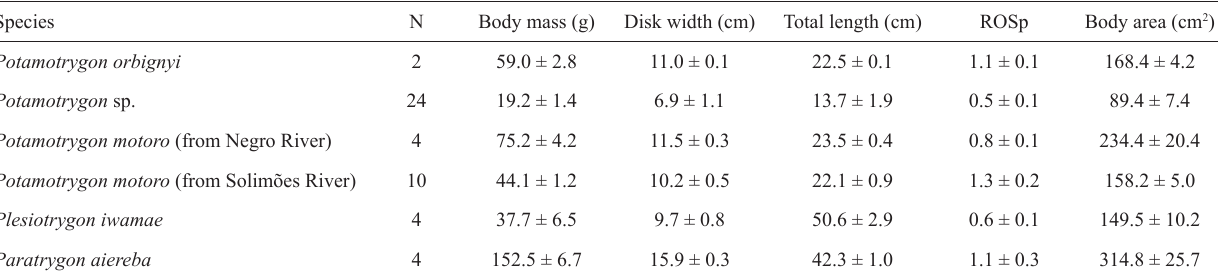
Table 2. Number of total filaments (mean ± S.E) on different gill arches among near-term potamotrygonid embryos. Potamotrygon Gill arches Potamotrygon sp. orbignyi